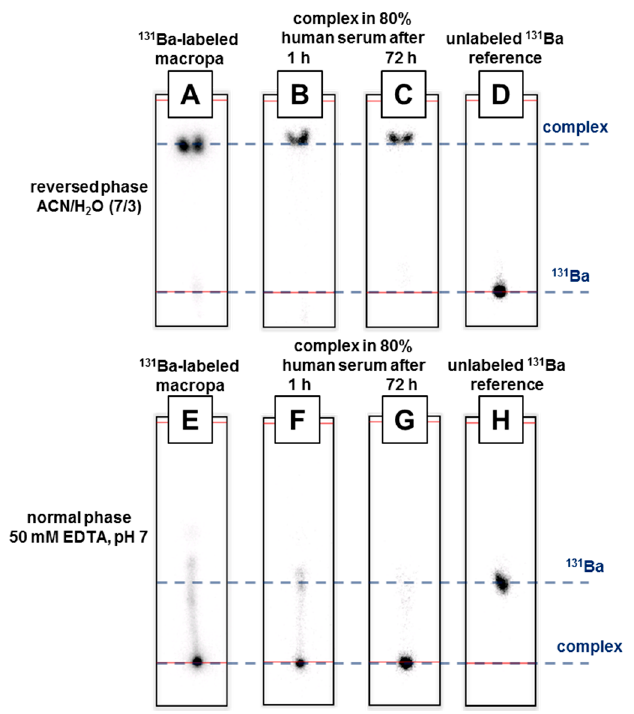
Figure 6. Radio-TLCs of 131 Ba-labeled macropa ( A and E ) in human serum for stability testing using RP TLC ( B and C ) and NP TLC ( F and G ) and free [ 131 Ba]Ba 2+ as reference ( D and H ).